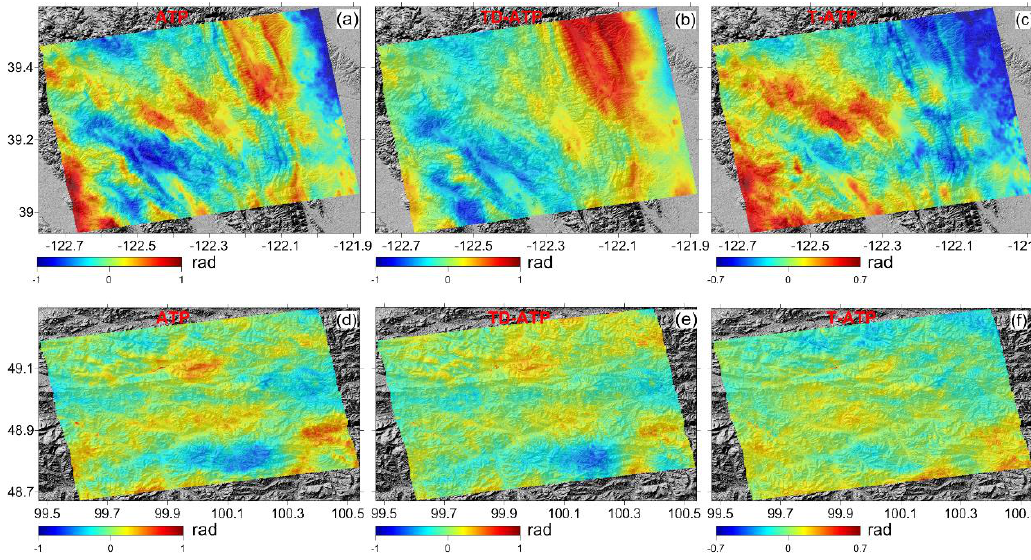
Figure 20. ( a ) ATP map, ( b ) TD-ATP map, and ( c ) T-ATP map for San Francisco test site. ( d ) ATP map, ( e ) TD-ATP map, and ( f ) T-ATP map for Moron Test site.